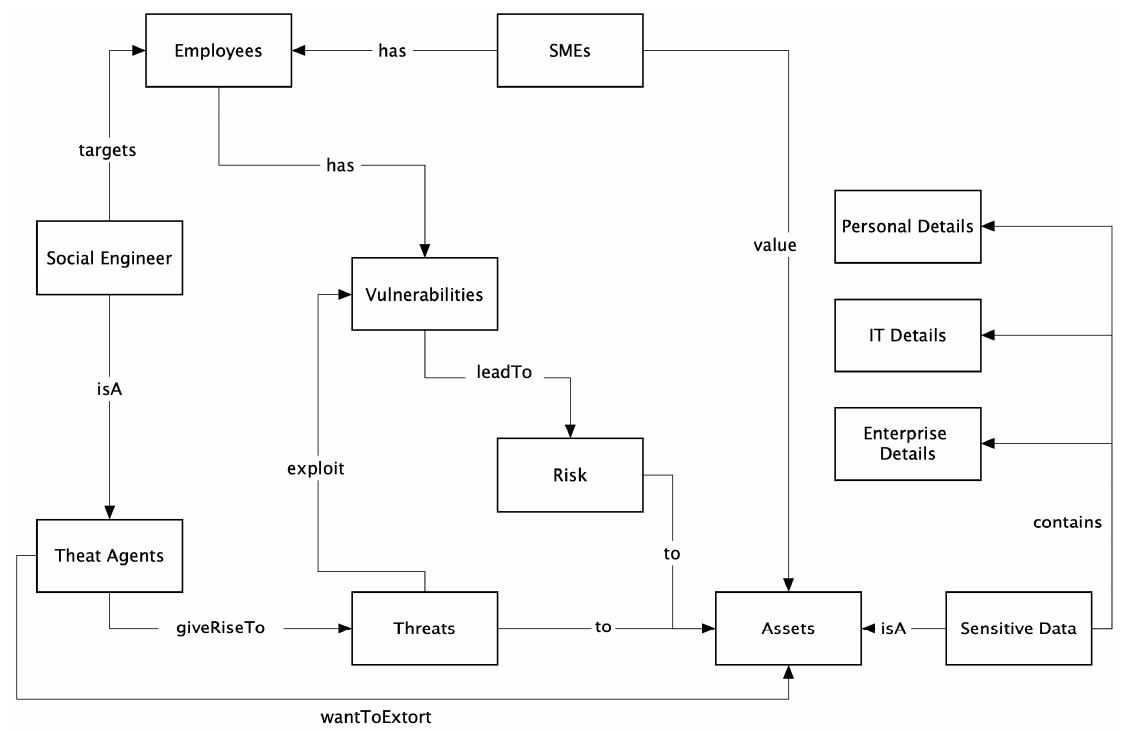
Figure 6. Concept map of the CSE a tt ack domain.